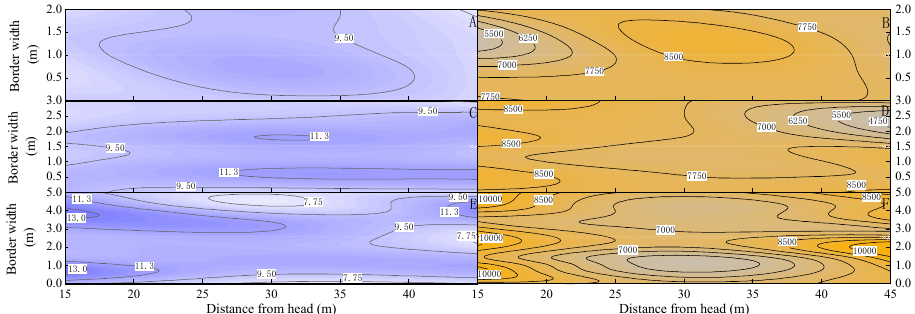
Figure 5. Distribution of soil moisture content ( A , C , and E ) and grain yield ( B , D , and F ) at different positions from the borders with a 45 mm irrigation quota. White lines indicate the positions of micro-spray tapes between borders.